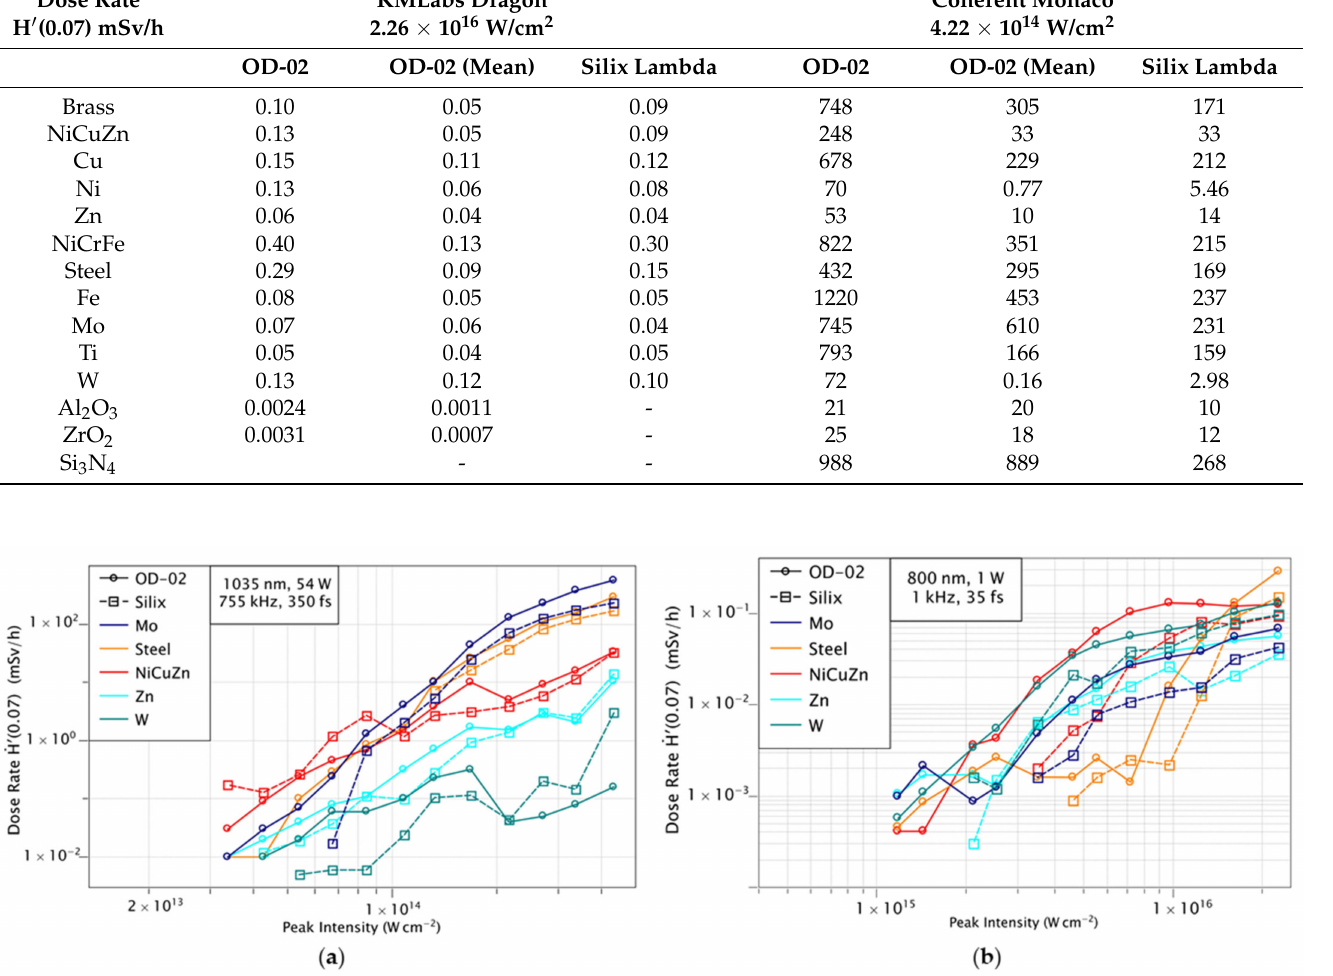
Figure 8. Comparison of the accumulated dose rates using Silix lambda and OD-02 detectors for an intensity range 5 × 10 13 and 5 × 10 16 W/cm 2 by tuning the laser pulse energy for Coherent Monaco ( a ) and KMLabs Dragon laser ( b ). The dotted line represents the dose measurement with the Silix and the solid line the dose measurement with the